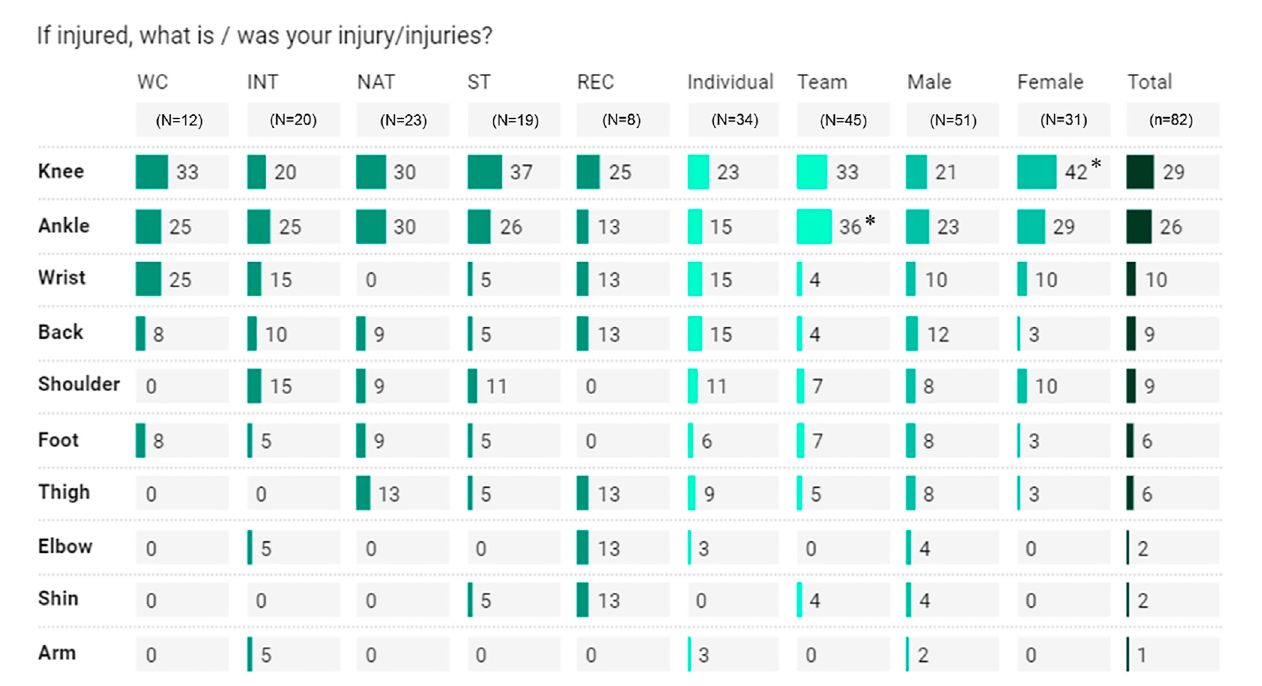
FIGURE 5 Injury prevalence as shown by muscle areas Percentage, within athlete classi fi cation, sport-type, and gender, represents “ yes ” answer, relative to “ no ” answer. WC, world-class; INT, international; NAT, national; ST, state; REC, recreational. *Signi fi cantly higher at p < .05 (within the speci fi c comparative variable).